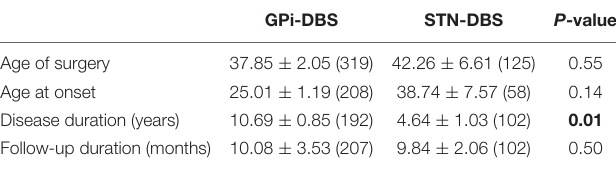
TABLE 1 | Pooled value of patient baseline characteristics a .